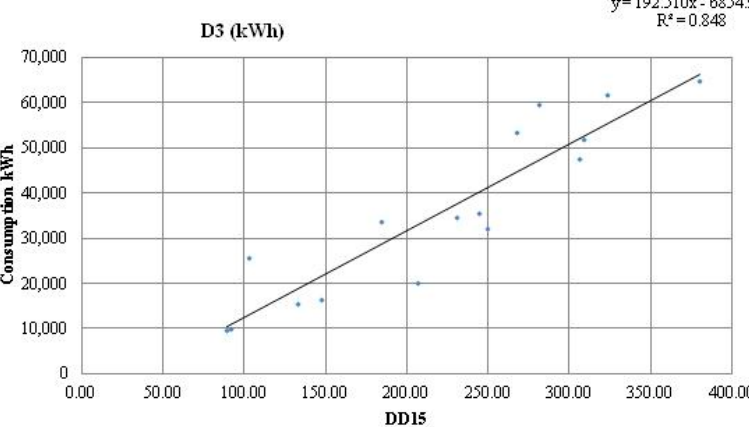
Figure 8. Linear regression model. D3 building (Centre for the Transfer of Applied Technologies (CTTA)).